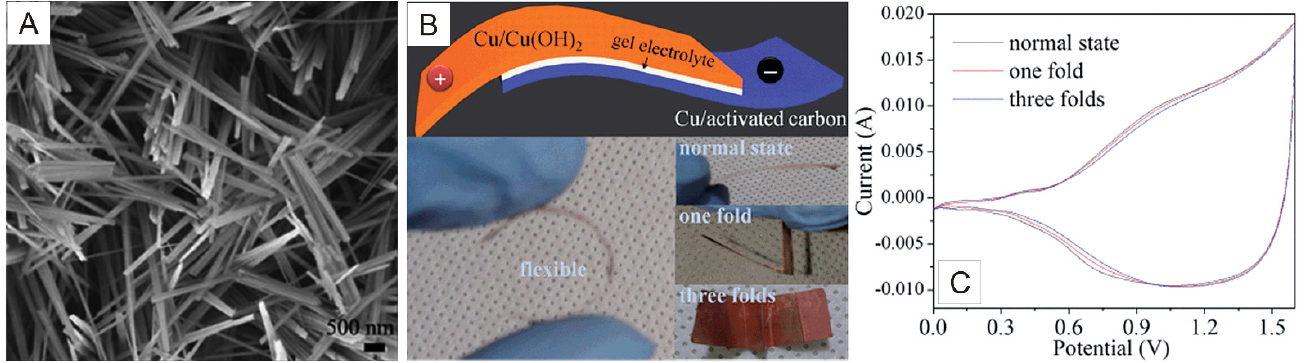
Figure 5. ( A ) SEM images of 3-D Cu(OH) 2 . ( B ) Graphics and photographic illustrations of a flexible and foldable Cu(OH) 2 //AC solid-state ASC. ( C ) CV curves of the ASC under different folding states. Adapted from [78] .